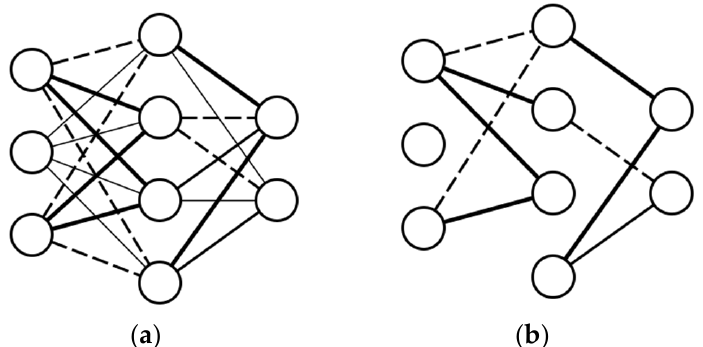
Figure 3. The difference between ANN architecture trained by using: ( a ) a backpropagation algorithm and ( b ) structural learning with a forgetting approach.